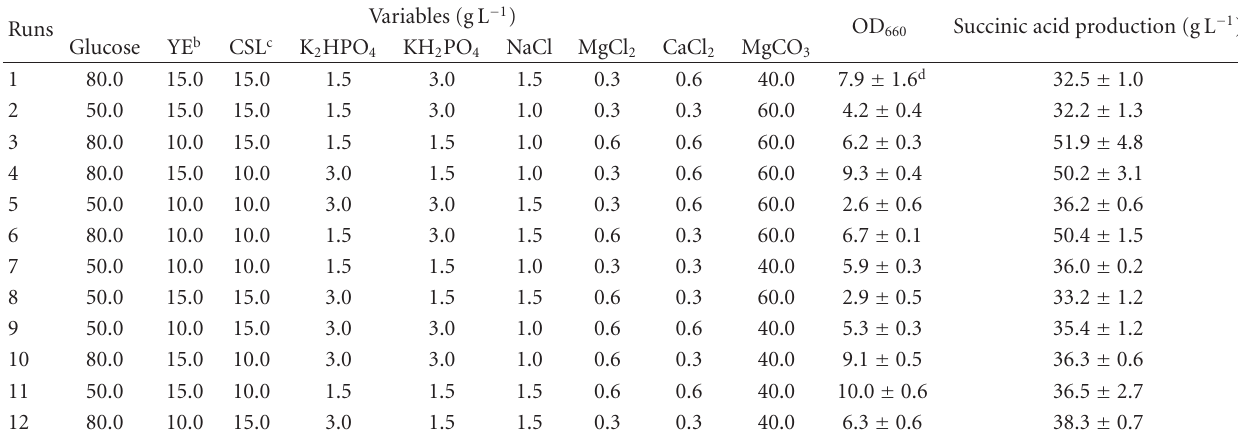
Table 1: The Plackett-Burman design experiment design matrix a and experimental results.